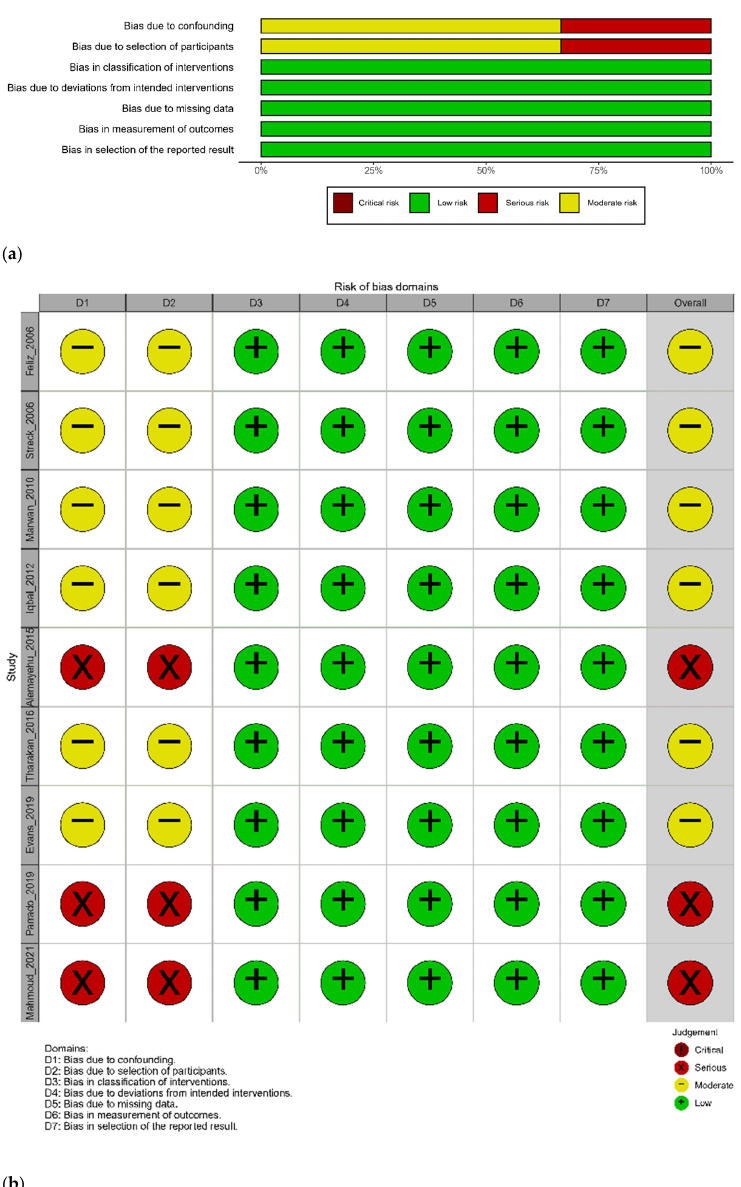
Figure 6. Risk of bias and applicability concerns graph ( a ) and summary ( b ): Review authors’ judgements about each domain presented as percentages across included studies.